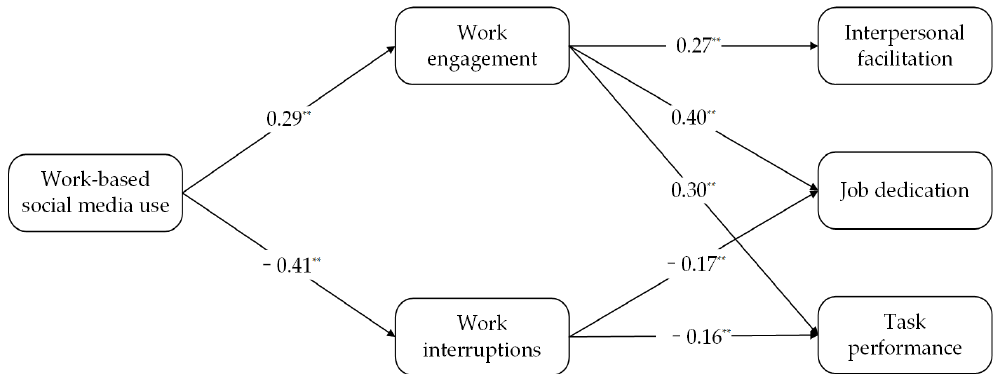
Figure 1. Results of structural equation modeling test. Notes: ** p < 0.01.